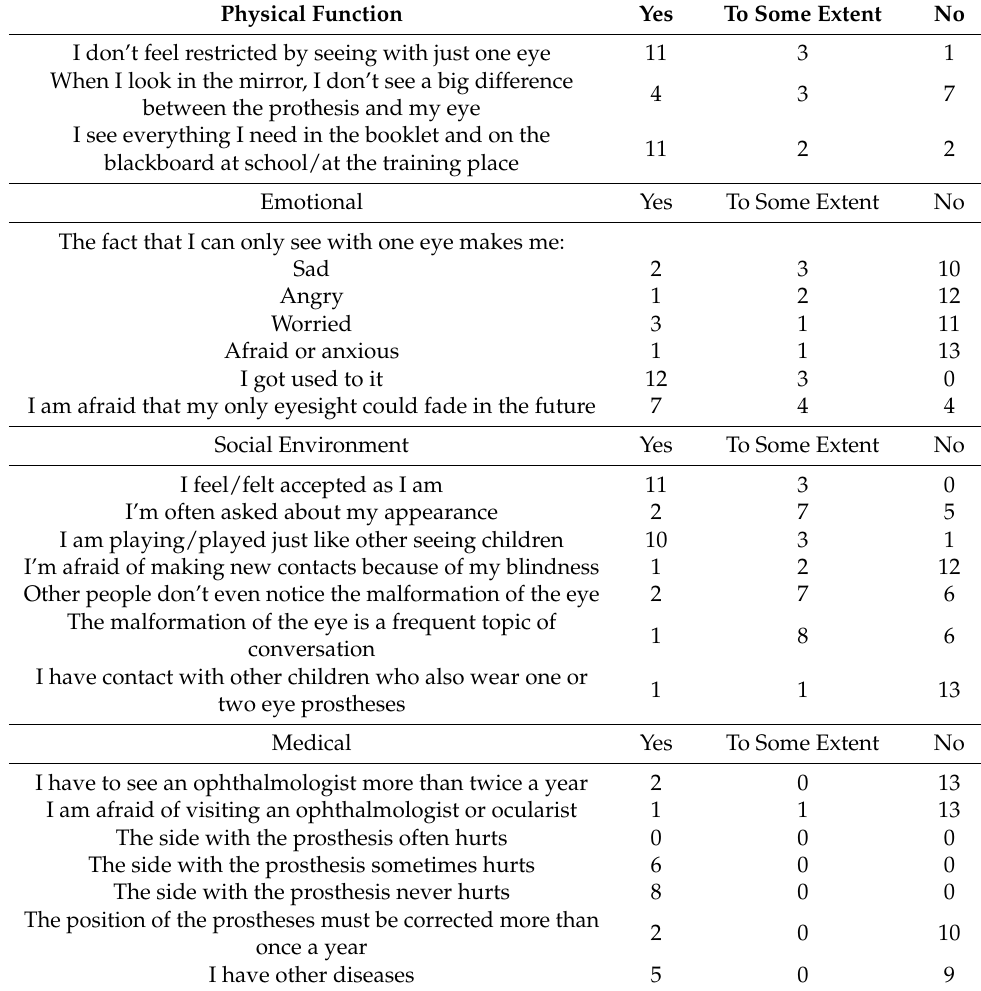
Table 2. Frequencies of responses of patients with unilateral clinical anophthalmos and blind mi- crophthalmos with healthy second